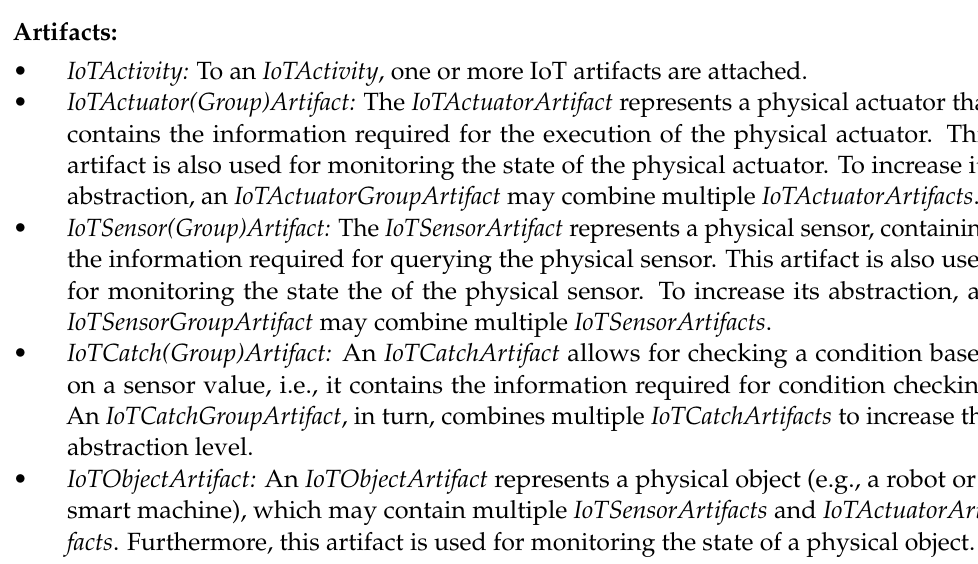
Figure 3. BPMNE4IoT